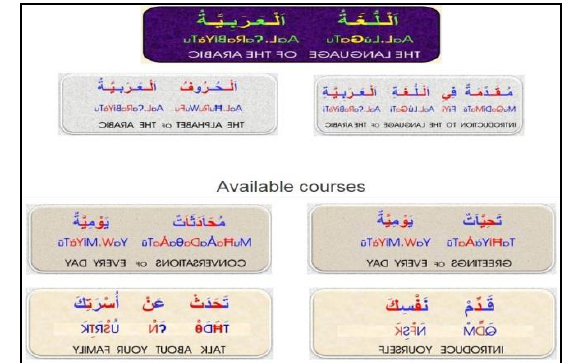
Figure 13. E-Learning system: lessons menu